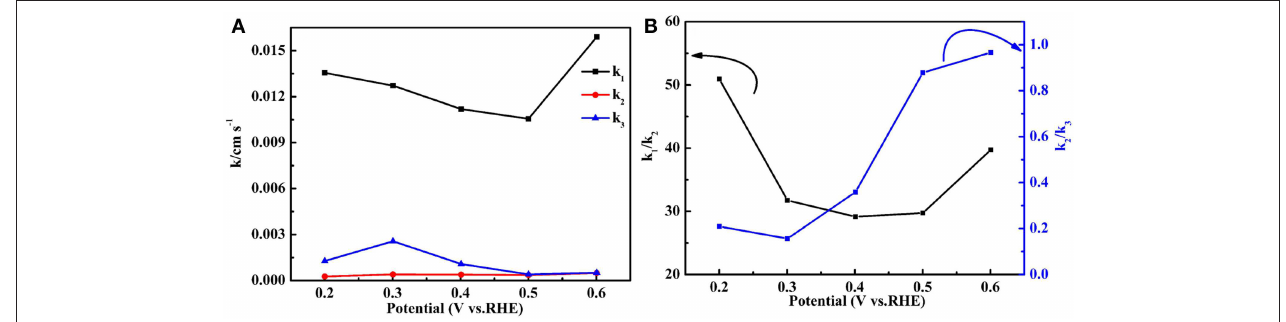
FIGURE 12 | The k 1 , k 2 , and k 3 values of the Fe-PIPhen/C catalyst (A) and the values of k 1 /k 2 and k 2 /k 3 (B)